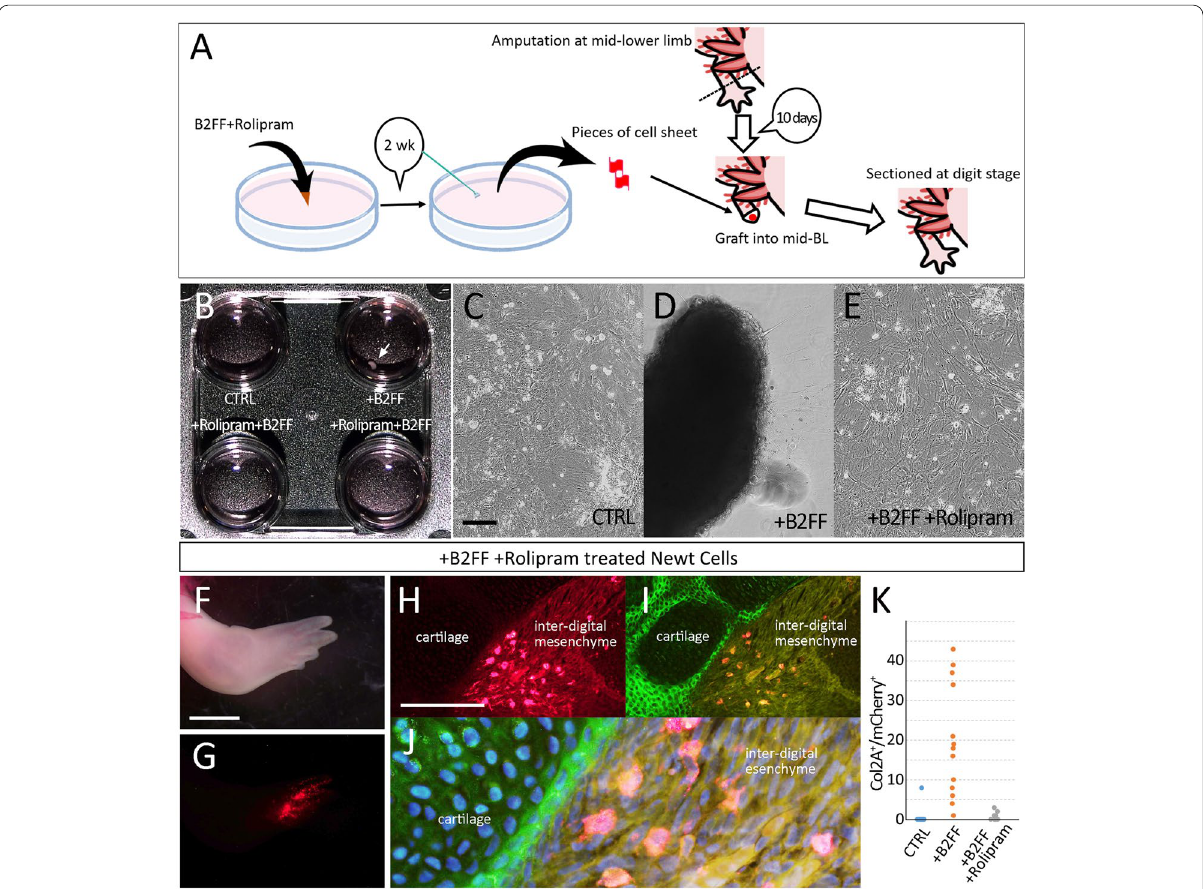
Fig. 8 Inhibition of the participation of dermis-derived newt cells into cartilage by Rolipram treatment. A the schematic diagram. B Rolipram treatment inhibited the formation of cell aggregate by B2FF application. C–E Cell morphology 2 weeks after the treatment. C the control. D The B2Ff treated cell. The aggregate was formed. E The Rolipram B2FF treated cells. No cell aggregate could be seen. F–J Distribution of the grafted + newt cells in axolotl limb regeneration. F The newt cell-grafted limb regenerates normally. G The grafted newt cells (red). H–J The distribution of the grafted newt cells and cartilages was visualized by immunofluorescence. J the high magnified and merged image of the H and I. Nucleai are shown in blue (Hoechst). K the plot of the number of the Col2A + mCherry + cells. The scale bars in C , F , and H are 500 μm, 2 mm, and 300 μm, respectively